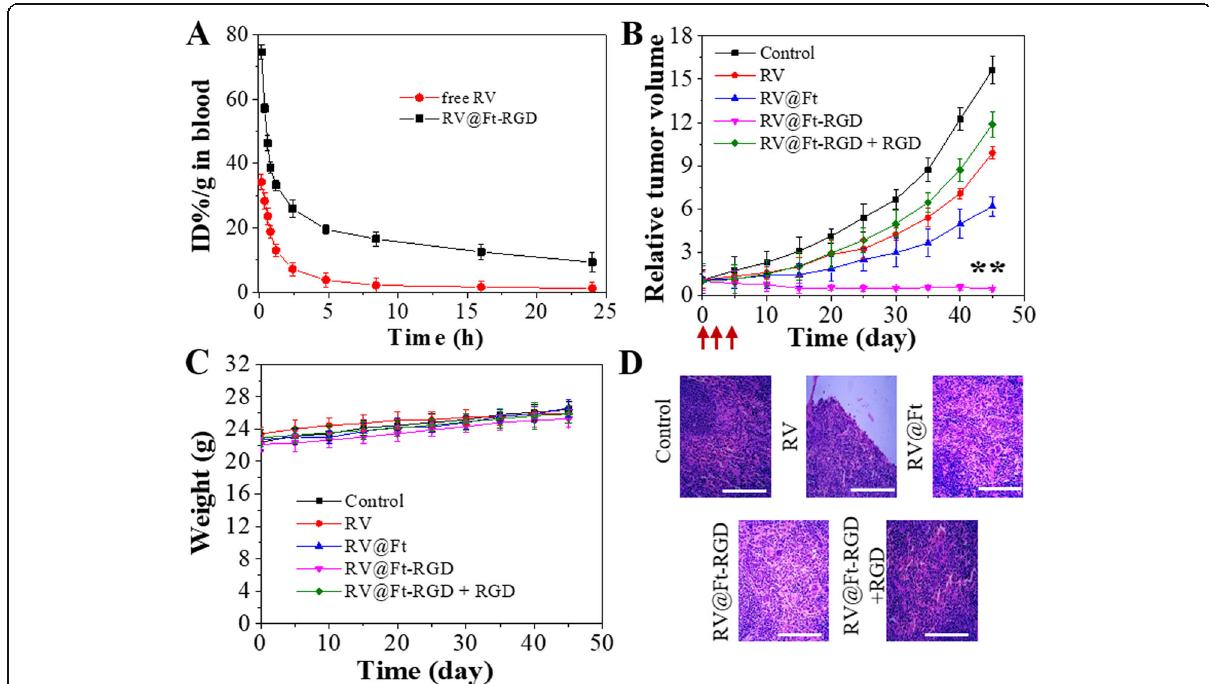
Fig. 7 a Circulation time of free RV and RV@Ft-RGD in blood. b The growth profile of A549 xenografted tumors after three-time intravenous injection of saline (control), RV, RV@Ft, RV@Ft-RGD + RGD, and RV@Ft-RGD. Red arrow indicates the injection time point. **P < 0.01, compared with other groups, respectively. c Body weight of tumor-bearing mice after various treatments. d Micrographs of H&E-stained tumor slices collected from different groups of mice after the end of the treatment. Scale bars are 50 μ